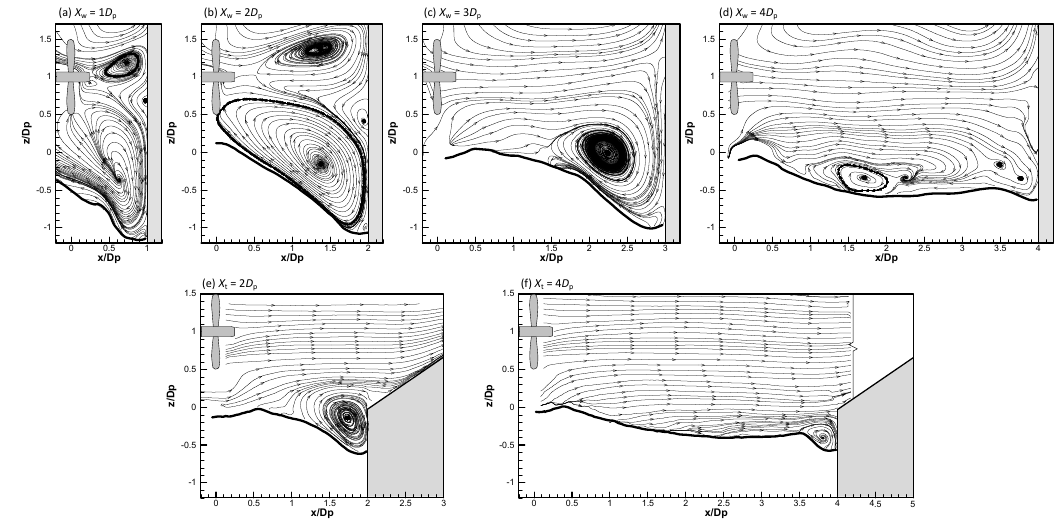
Figure 4. Comparison of streamline plots of the asymptotic state at different wall clearances (vertical quay wall) and toe clearances (slope quay wall): ( a ) X w = 1 D p ; ( b ) X w = 2 D p ; ( c ) X w = 3 D p ; ( d ) X w = 4 D p ; ( e ) X t = 2 D p ; ( f ) X t = 4 D p . Note: ( e ) and ( f ) are reproduced from Wei and Chiew [10] .